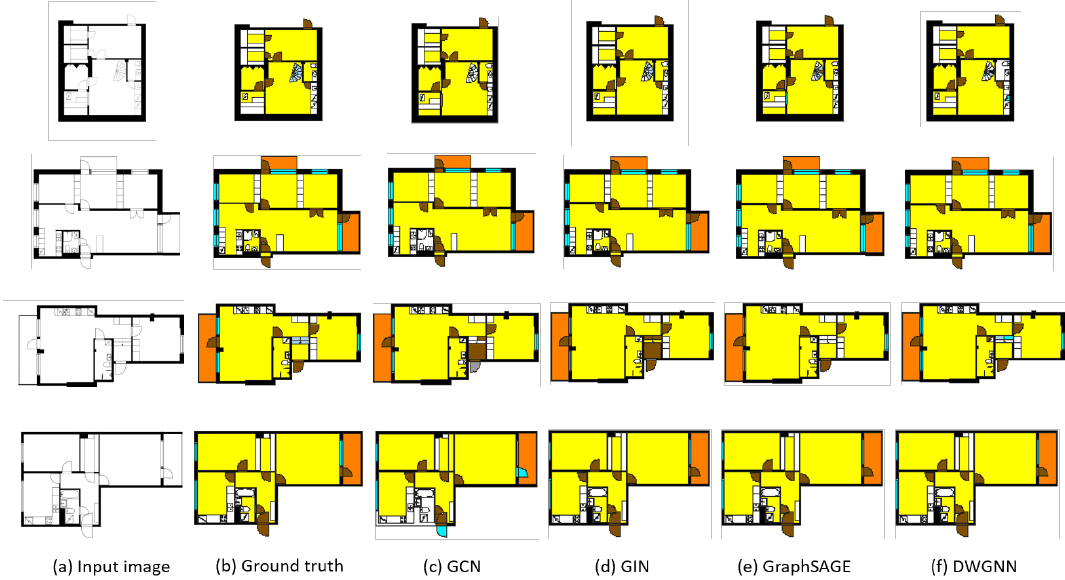
Figure 5. Examples of input image ( a ) and ground truth ( b ), and visual comparison of indoor element classification results by GNN models for transductive learning ( c , d ) and inductive learning models ( e , f ). The element class “outer space” is erased for